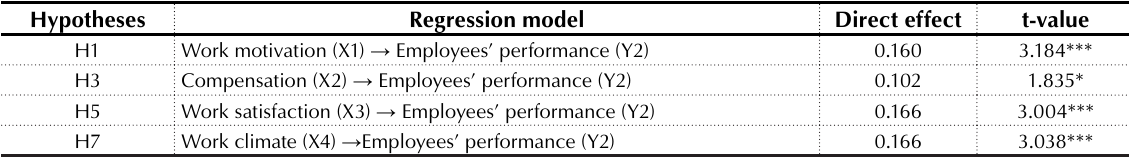
Table 1. Results of test on direct effect of